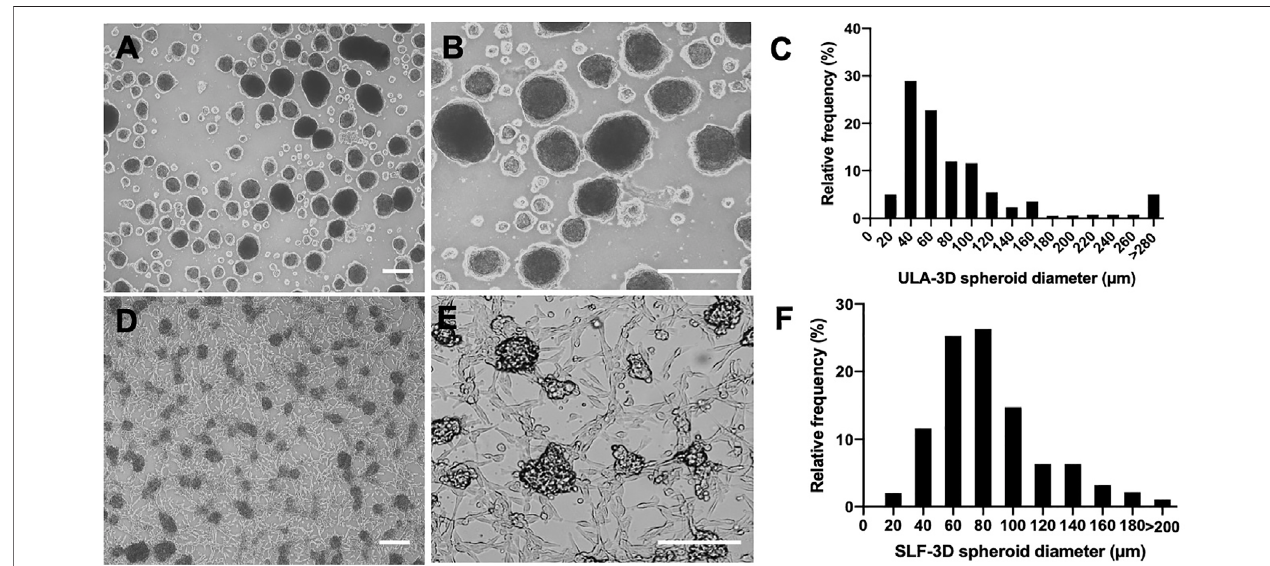
FIGURE 2 | Comparison of the diameter distribution of the two methods (SLF-3D and ULA-3D spheroid methods). The morphology and distribution of spheroids generated with the self-feeder 3D (SLF-3D) culture method compared with spheroids from the traditional ultra-low attachment 3D (ULA-3D) method were compared.